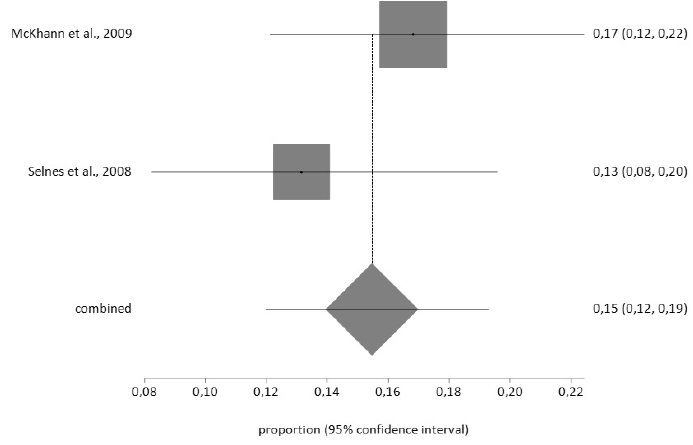
Figure 8. Forest plot for pre-CABG depression using Centre for Epidemiological Studies Depression Scale (CES-D).